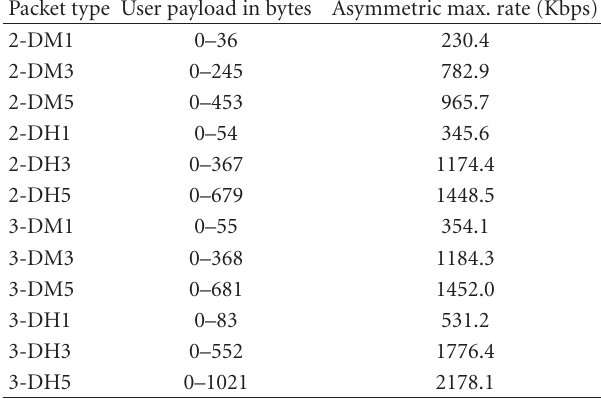
Table 1: Bluetooth EDR ACL packet types, including additional DM packets. (Length and master to slave bitrates, for a single ACL master-slave logical link, with DM = data medium rate (FEC added) and DH = data high rate (no FEC). 2-DH3 is 2.0 Mbps modulation three time-slot